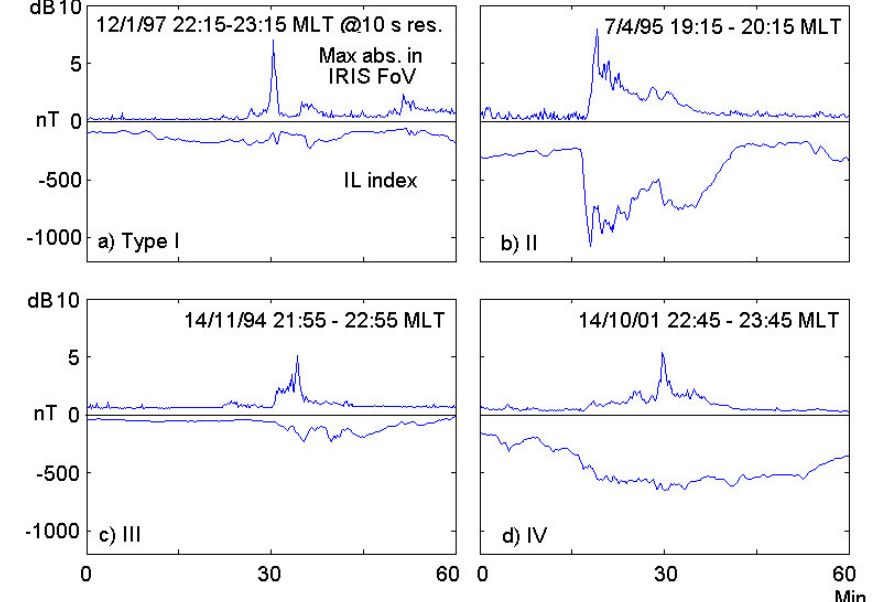
Fig. 1. Typical examples for 4 types of absorption spike events. Data are maximum absorption in IRIS field of view in dB and IL index in nT both at 10-s resolution and in 1-h